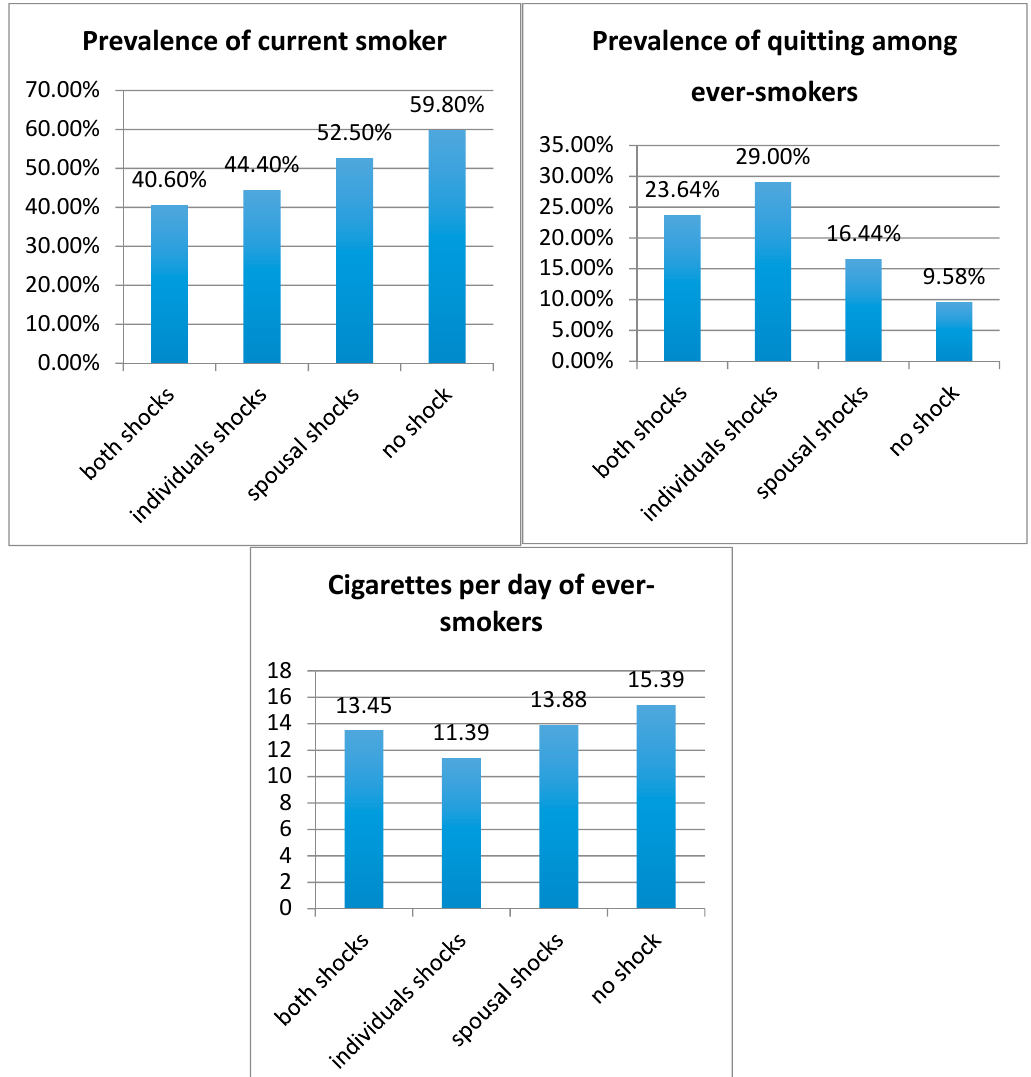
Figure 1. Relationship between health shocks and smoking behaviors